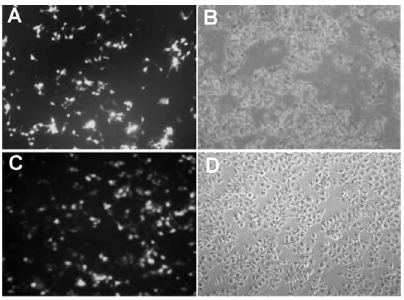
Figure 1. Transfection efficiency in Huh 7 and Hep G2 cells. Both Huh 7 (A and B) and Hep G2 (C and D) cells were transfected with eGFP-N1 plasmid using the similar transfection conditions as HBx. After 48 hours of transfection, the cells were observed (10 6 magnification). Both A and C are fluorescent pictures and B and D are corresponding phase-contrast pictures.